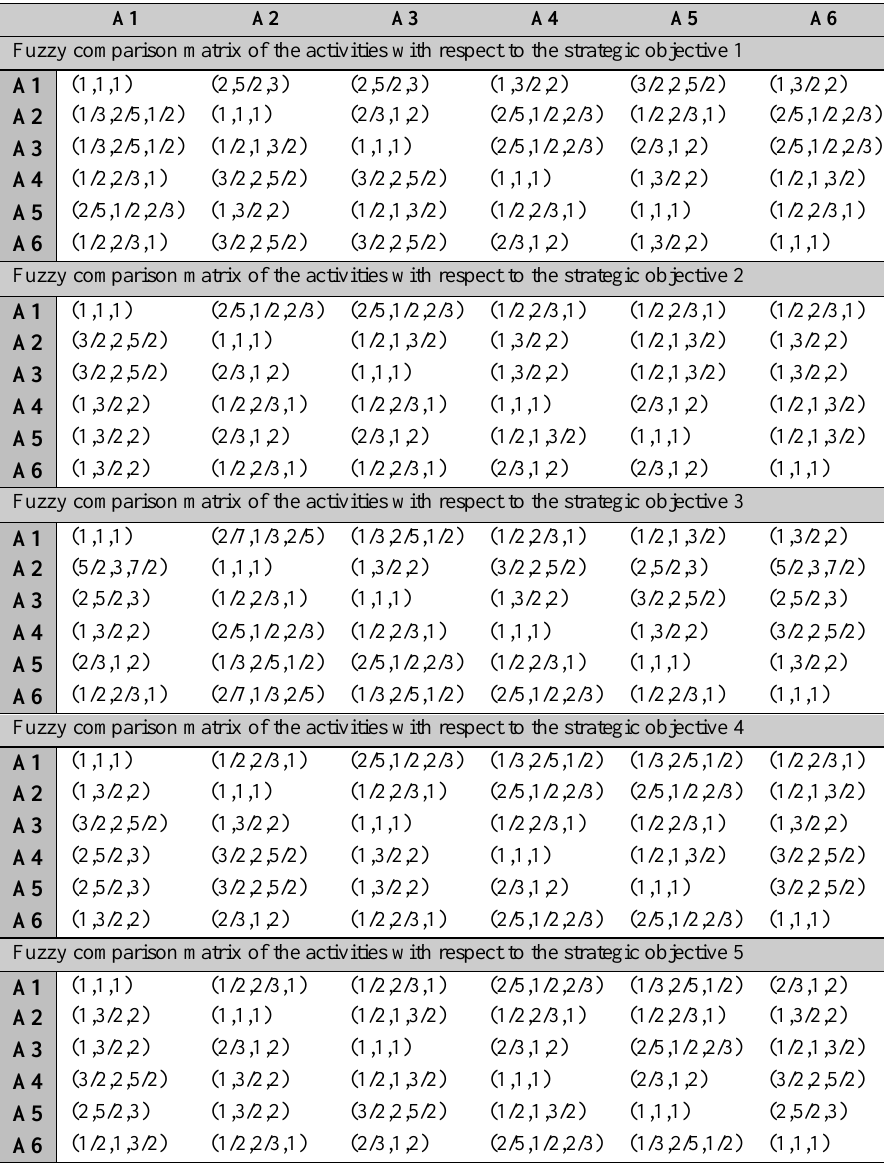
Table 4. Fuzzy comparison of activities with respect to the each strategic objective